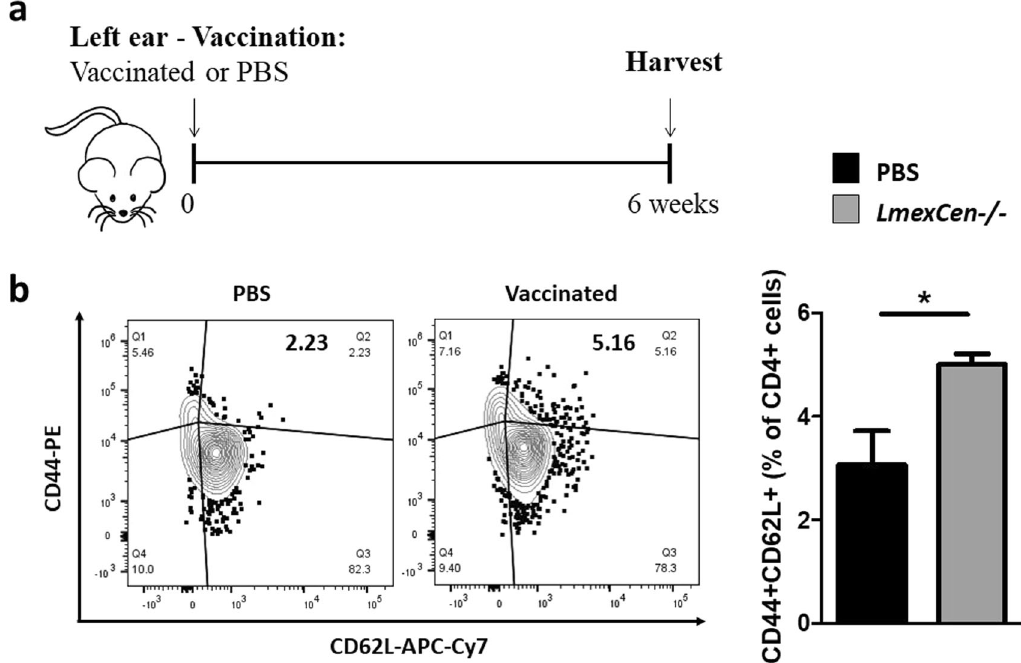
Fig. 5 LmexCen − / − immunization promotes generation of T central memory cells in BALB/c mice. a Schematic of the vaccination study design for BALB/c mice. b Percentage of CD4 + CD44 + CD62L + T cells in the draining lymph nodes of PBS-injected mice and mice immunized with LmexCen − / − parasites at 6 wpi analyzed via fl ow cytometry. Data show one representative experiment with mean ± SEM, N = 3 for each group. Unpaired two-tailed Student ’ s t -test was performed to compare statistical signi fi cance. A P -value < 0.05 was considered signi fi cant. In all panels * represents P ≤ 0.05, ** represents P ≤ 0.01, and *** represents P ≤